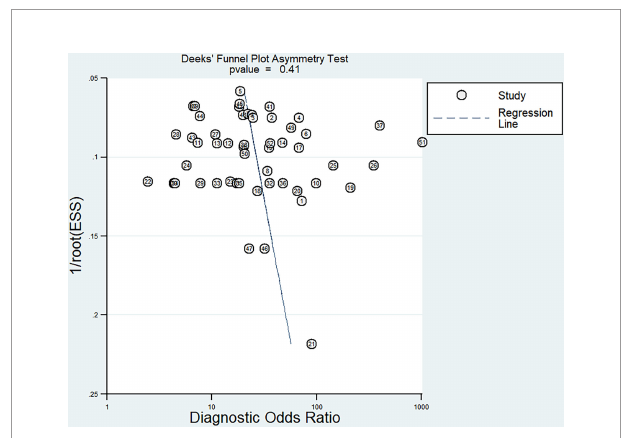
FIGURE 8 | Funnel plot for determining publication